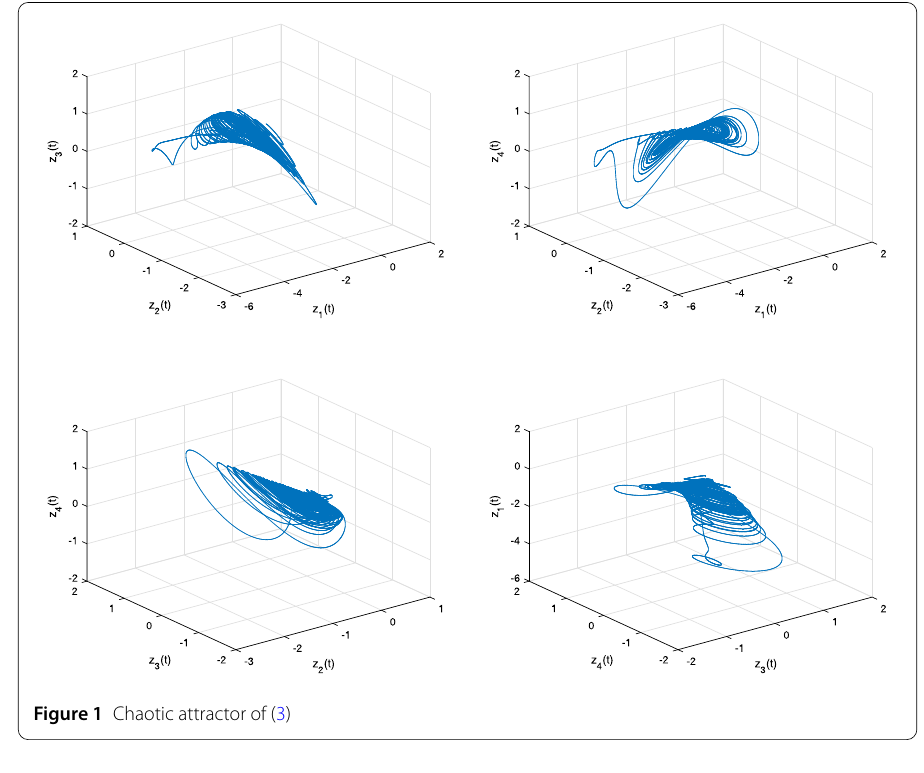
Figure 1 Chaotic attractor of (3)